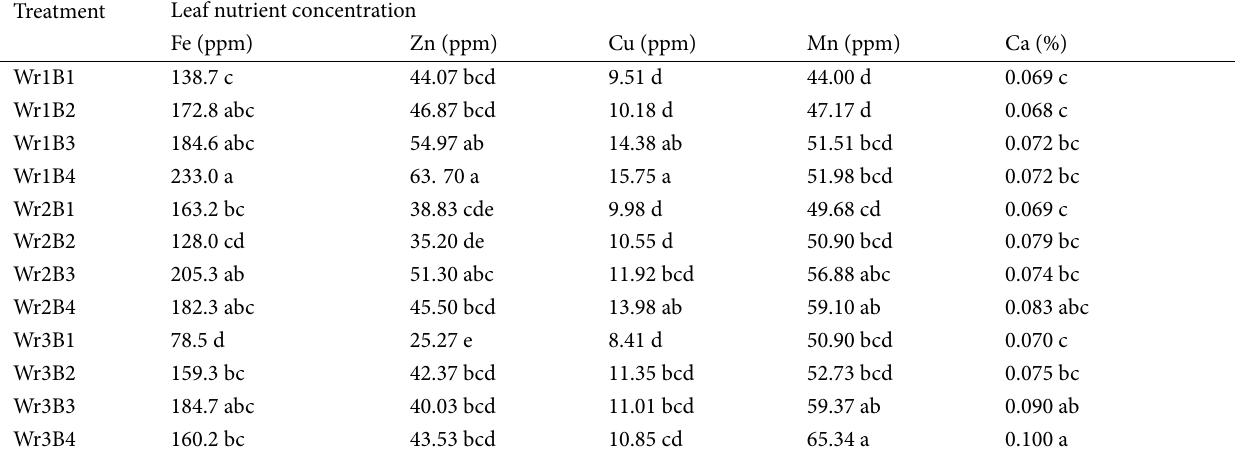
Table 7 Leaf nutrient concentrations of melon plants in different levels of biochar and drought stress. Treatment